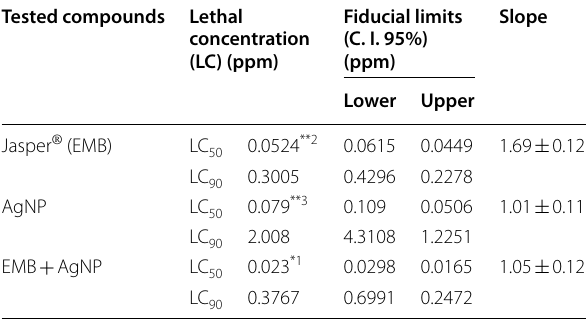
Means followed by the same letter in a column are not significantly different at the 5% level of probability (Duncan’s Multiple Range Test) [14]